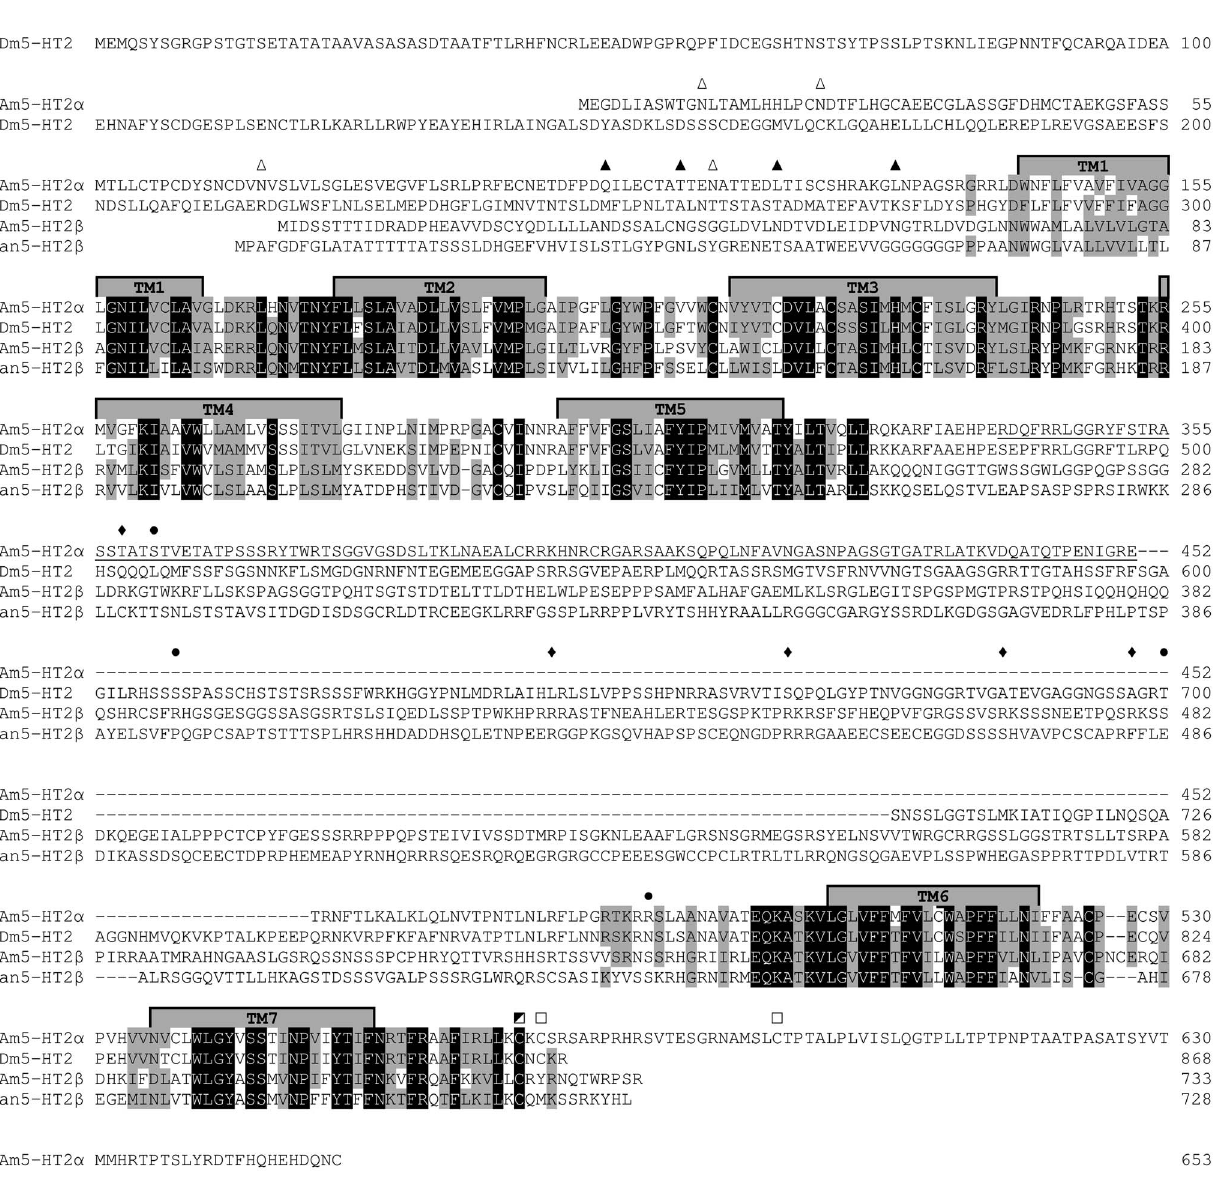
Figure 2. Amino-acid sequence alignment of Am5-HT 2 a , Am5-HT 2 b , and orthologous receptors from Drosophilamelanogaster (Dm5- HT 2 ; accession no. CAA57429) and Panulirusinterruptus (Pan5-HT 2 b ; AAS57919). Identical residues between all four receptors are shown as white letters against black, whereas conservatively substituted residues are shaded. Putative trans-membrane domains (TM1–7) are indicated by gray bars. Putative consensus sites for post-translational modifications in Am5-HT 2 a and Am5-HT 2 b are indicated by open and filled symbols, respectively: N-glycosylation sites are shown as triangles, PKA phosphorylation sites as diamonds, PKC phosphorylation sites as circles, palmitoylation sites as squared boxes. Underlined letters represent the region within the CPL3 of Am5-HT 2 a used to raise specific antibodies (see Fig. S2). The amino acid position is indicated on the